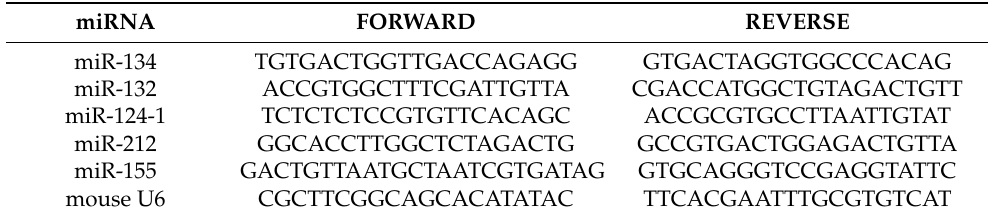
Table 1. The used primer sequences for the examined miRNAs (miR-124-1, miR-212, miR-132, miR-134, and miR-155) and the internal control gene (mouse